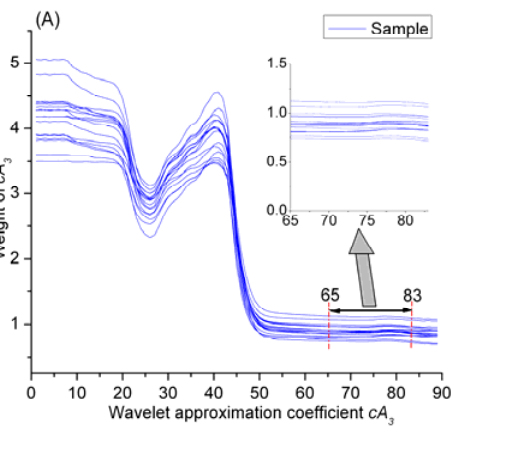
Figure 8. Reconstruction of approximation at level 3 ( A ) Wavelet approximation coefficients at level 3 and ( B ) Reconstructed